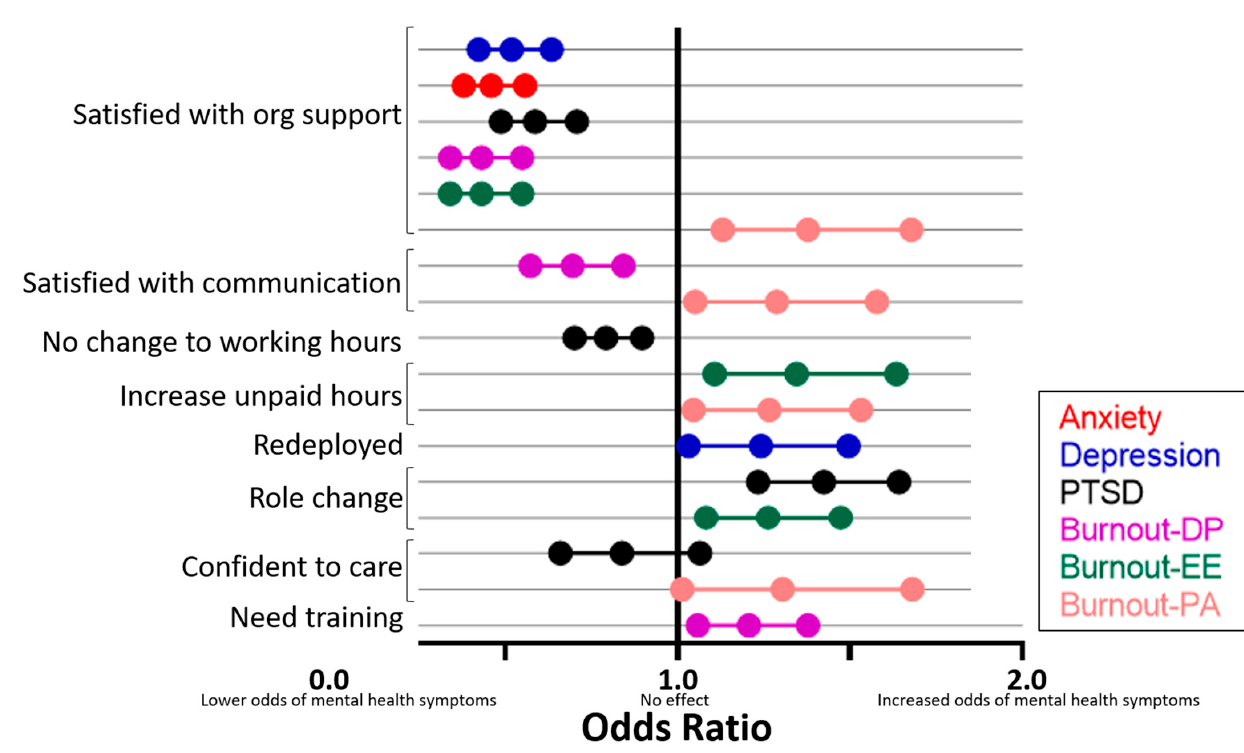
Figure 1. Bars are indicative of odds ratio and 95% confidence intervals. Colour key represents predictors for each validated scale outcome: Anxiety (Generalised Anxiety Disorder Scale); Depression (Patient Health Questionnaire); PTSD (post-traumatic stress disorder; Impact of Events Scale); Burnout (Maslach Burnout Inventory; DP = Depersonalisations; EE = Emotional Exhaustion; PA = Personal Accomplishment). Lower odds ratio for PA indicates poorer outcomes. Reference categories—satisfied with organisational support vs. neutral, satisfied with workplace communications vs. neutral, no change to working hours vs. change, increased unpaid hours vs. negative response, redeployed vs. negative response, role change vs. negative response, confident to care vs. neutral, needs training vs. negative